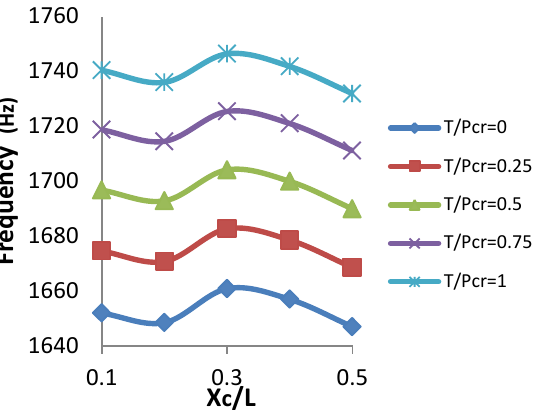
Fig. 7. Third frequency of cracked beam, subject to tensile